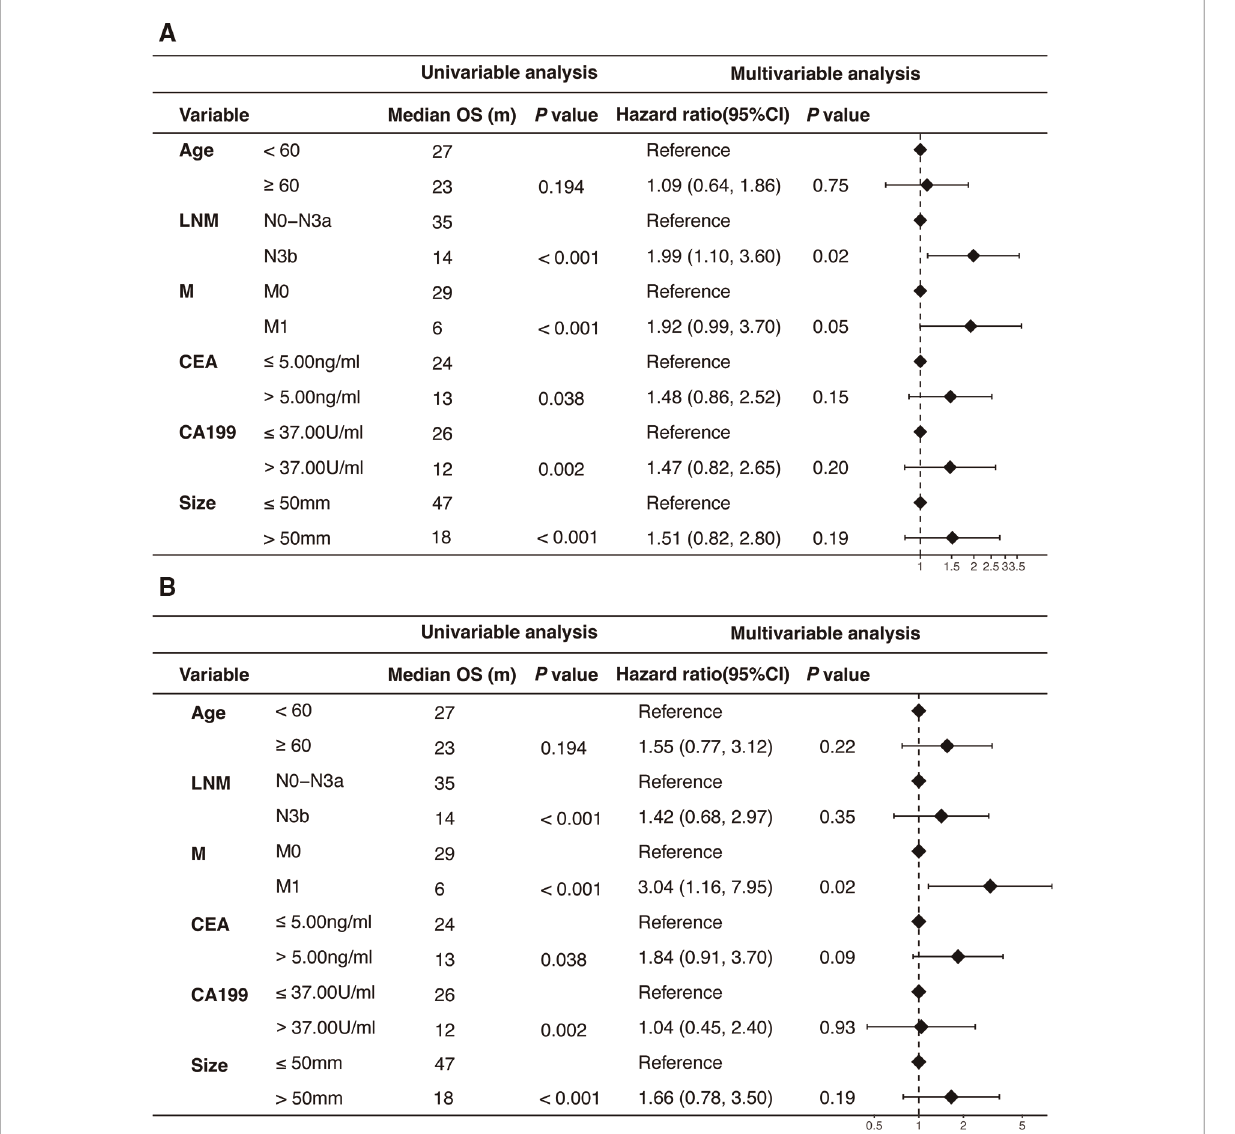
FIGURE 2 Cox proportional hazard regression models and forest plot for overall survival. ( A ) Forest plot displaying the results of hazard ratio for overall survival of patients with Borrmann type IV gastric cancer; ( B ) Forest plot displaying the results of hazard ratio for overall survival of patients with B-4 GC after receiving R0 resection. (LNM, lymph node metastasis; M, distant metastasis; CI, con fi dence